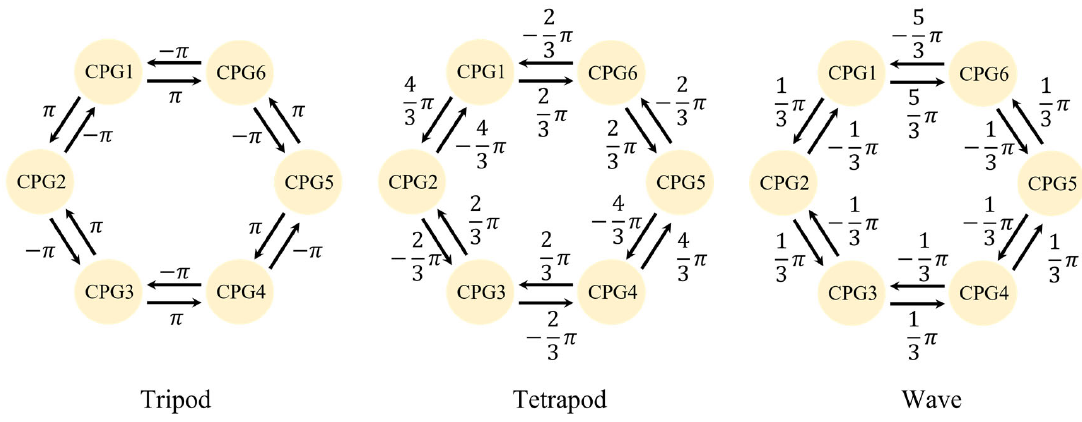
Figure 3. The phase difference corresponding to common gaits.